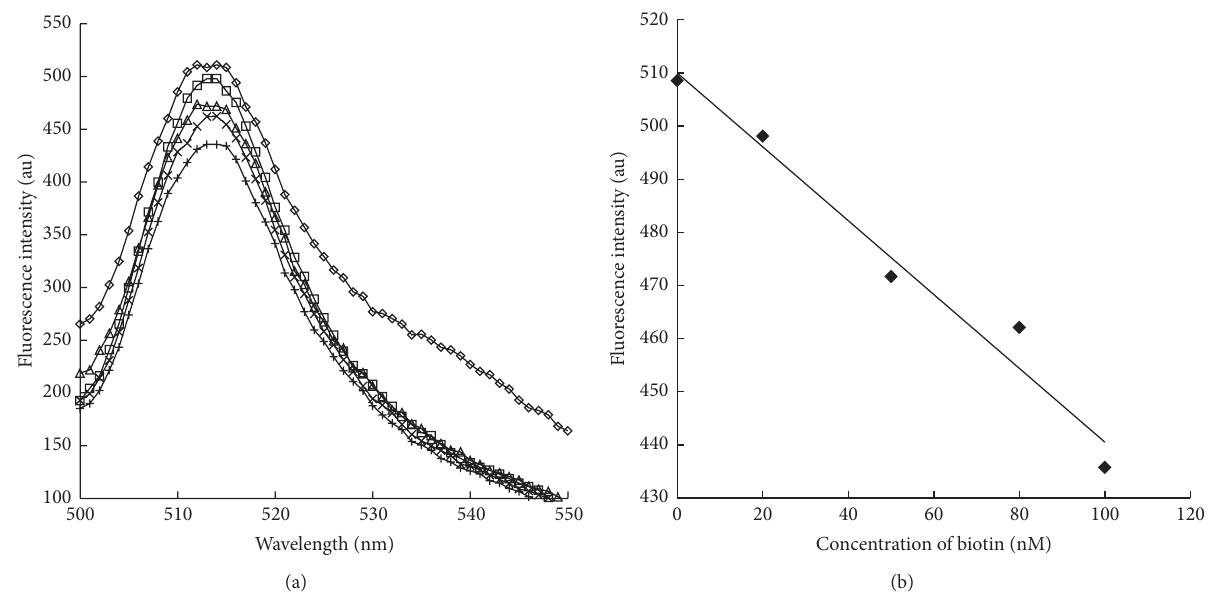
Figure 4: (a) Fluorescence spectra of the Trp120BFLAF mutant streptavidin in the presence of the pairs of 0nM (– ◊ –), 20nM (– ◻ –), 50nM (– 󳵻 –), 80 nM (– × –), or 100 nM (–+–) of natural biotin and 100nM of biotin-(AC 5 ) 2 -hydrazide. Marked fluorescence enhancement was observedfortheTrp120BFLAFmutantstreptavidinbyadditionofbiotin-(AC 5 ) 2 -hydrazide.DecreaseoffluorescenceofTrp120BFLAFmutant streptavidin was observed upon competitive biotin addition in the presence of 100nM of biotin-(AC 5 ) 2 -hydrazide. (b) The fluorescence intensities of the Trp120BFLAF mutant streptavidins in the presence of the pairs of various concentrations of natural biotin and 100nM of biotin-(AC 5 ) 2 -hydrazide at 514nm were plotted. fluorescence intensity (au) of the Trp120BFLAF mutant streptavidin depended on the concentration of free biotin. All of the fluorescence spectra of mutant streptavidins were excited at 490